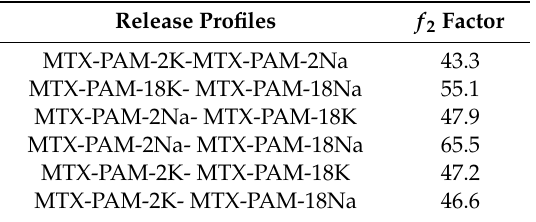
Table 2. Similarity factor ( f 2 ) of polymeric nanoparticulate systems at a pH of 7.4.